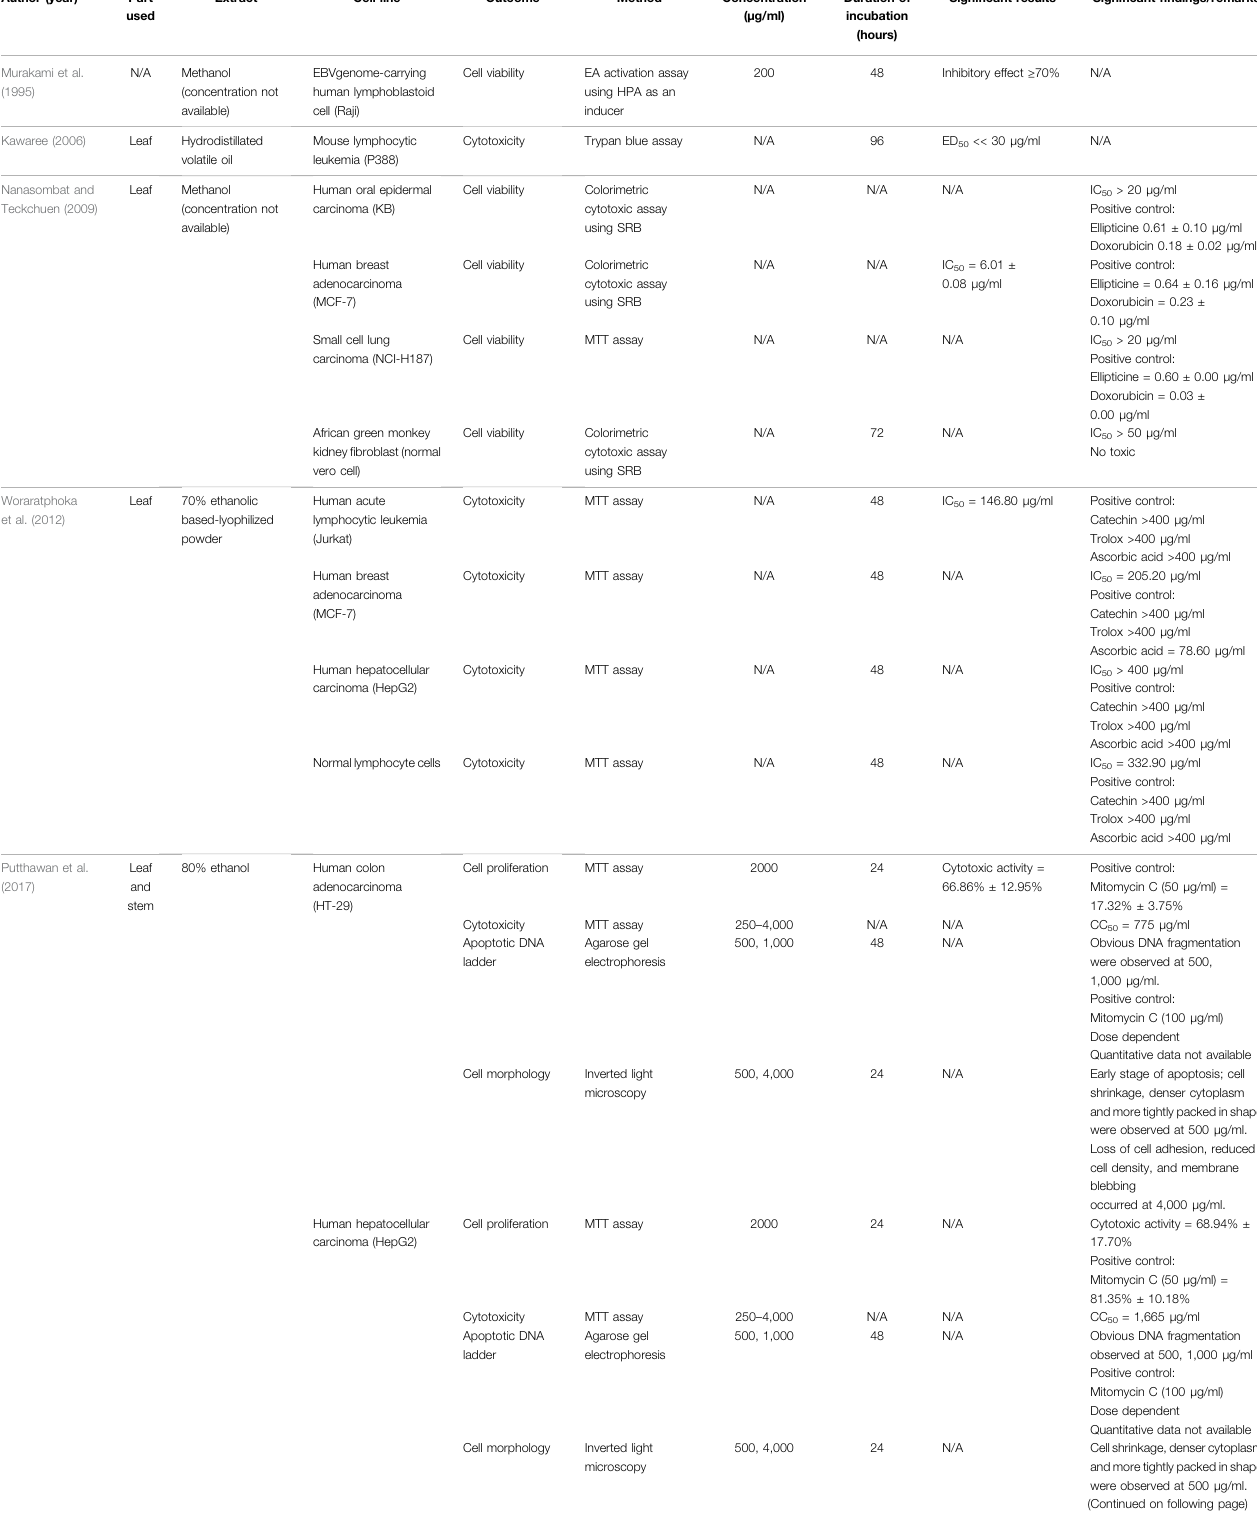
TABLE 2 | In vitro anticancer activity of P. odoratum